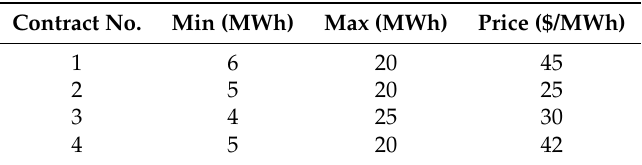
Figure 3. Observed mean day-ahead (DA) market prices and customers’ aggregated base demand. Table 1. Parameters of bilateral